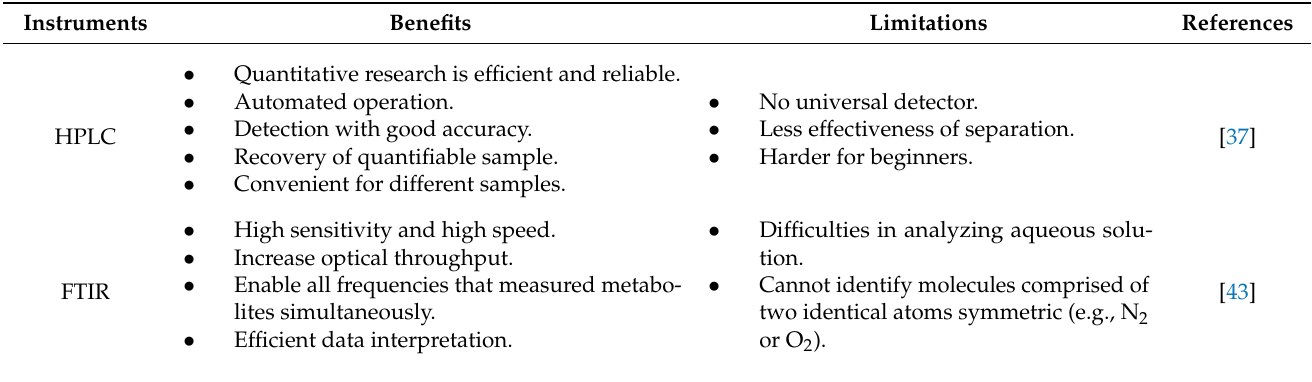
Table 3. Benefits and limitations of FTIR